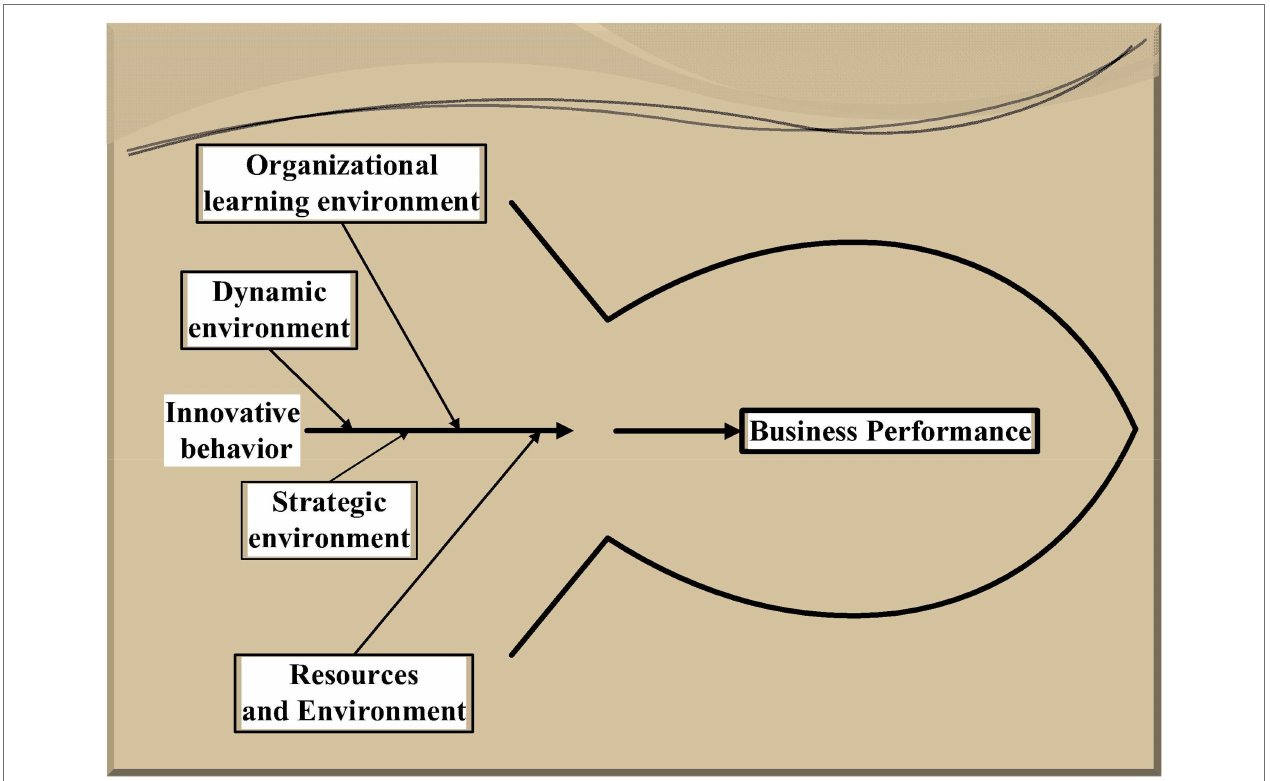
FIGURE 5 | Schematic diagram of model